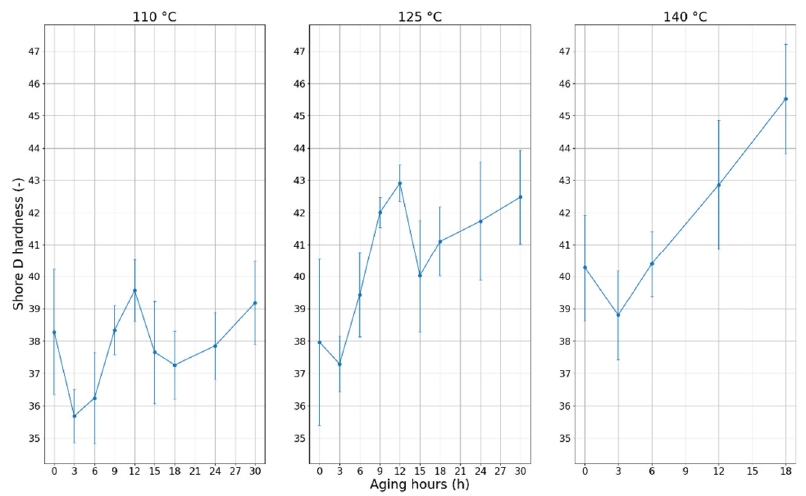
Figure 6. Changes of the hardness of PVC cable samples with aging time at each temperature.